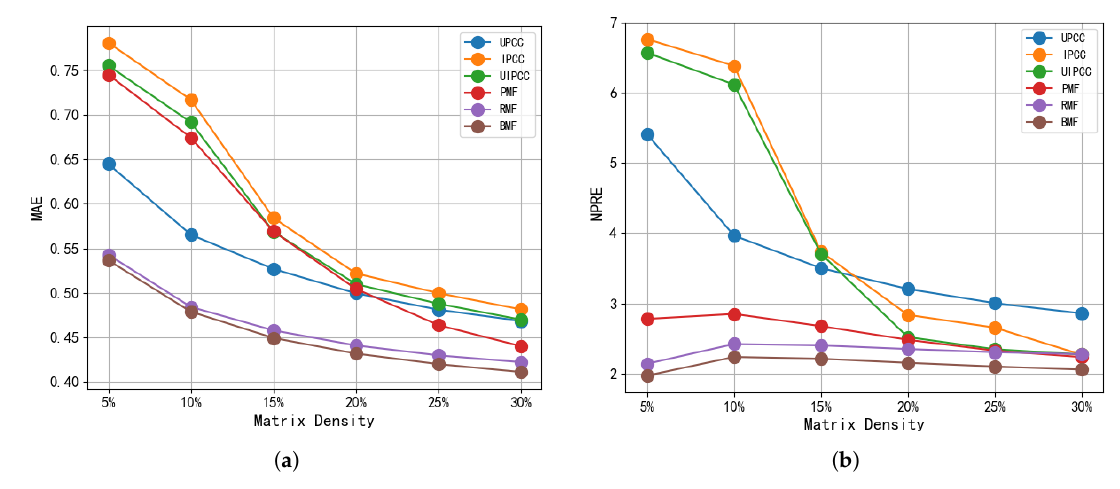
Figure 5. Impact of matrix density. ( a ) MAE; ( b )